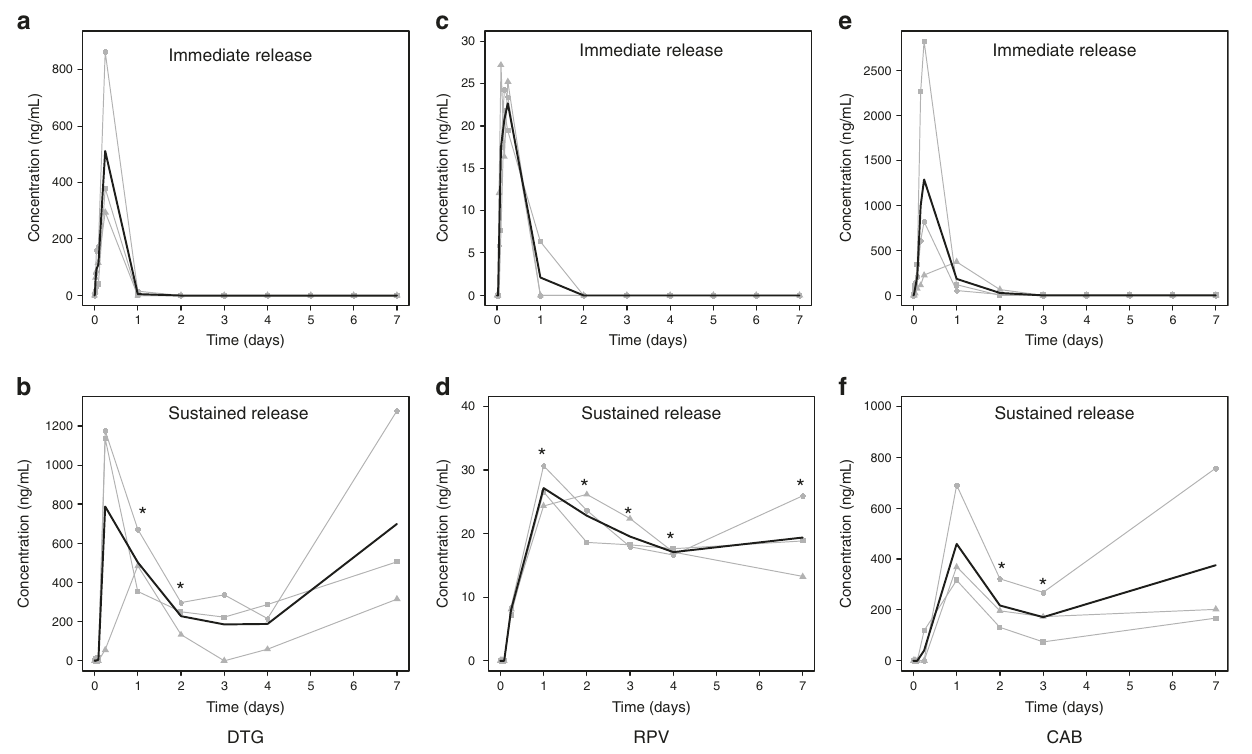
Fig. 4 Plasma pharmacokinetics of immediate release and sustained release antiretrovirals. The concentration time pro fi les of ( a ) DTG immediate release ( b ), DTG sustained release ( c ), RPV immediate release ( d ), RPV sustained release ( e ), CAB immediate release and ( f ) CAB sustained release are shown. Each dosage form was tested in three animals, and plasma samples from each animal were processed three times. Data was fi rst averaged within each animal (shown by the grey lines) and then between animals in each treatment group (shown by the black line). *indicates p < 0.05, two sample t